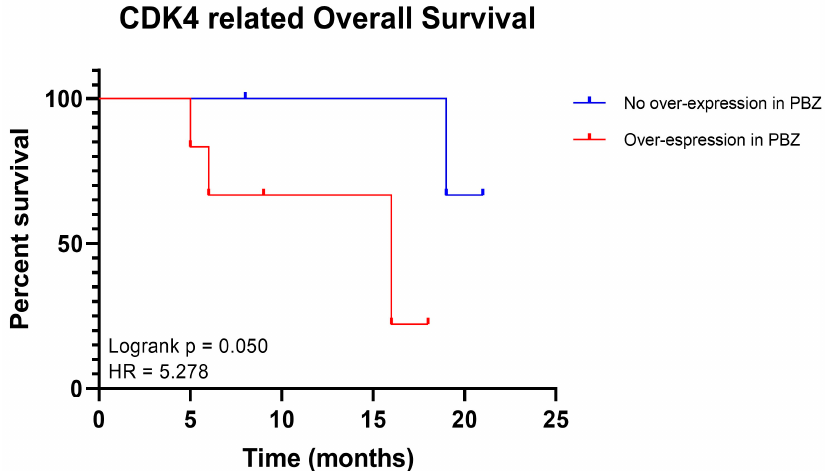
Figure 3. Kaplan–Meier curves performed on patients enrolled in the study. Survival analysis displays the estimated survival for patients without the over-expression of CDK4 in their peritumoural brain zone (PBZ) (in blue) or patients with the over-expression of CDK4 in their PBZ (in red). Timing is expressed in months. Log-rank p values and hazard ratio (HR) are